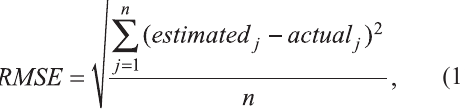
Table 9. Proposed final regression equation applied in each duration zone Duration Start time of the Finish time of the zone zone (%) zone (%)